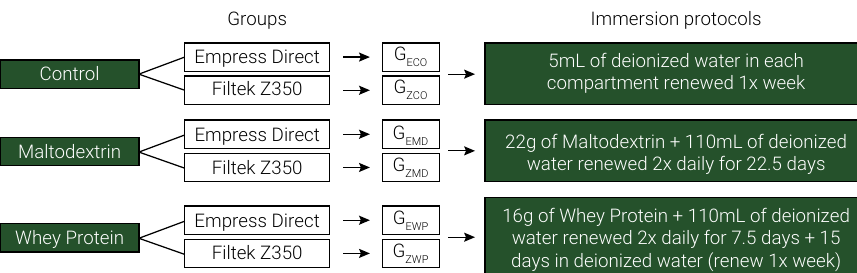
Figure 2. Description of the groups and immersion protocols